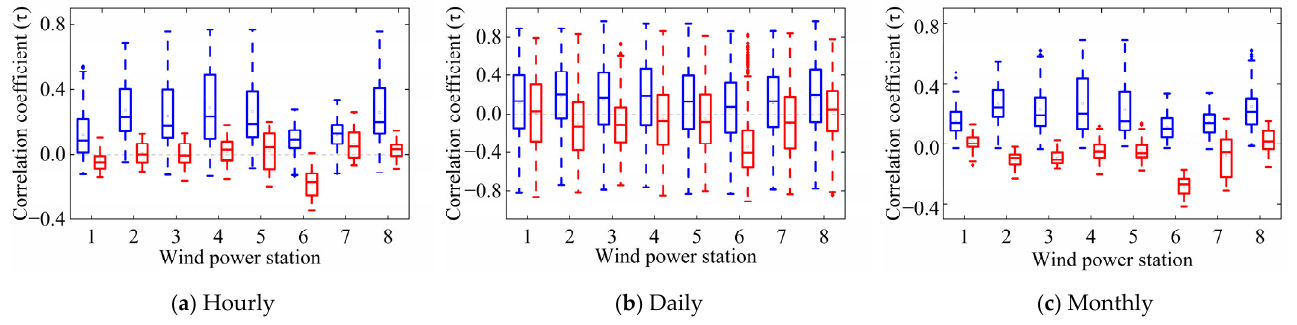
Figure 3. The fi rst type of complementary indicator under di ff erent time scales (the blue box represents the wind-wind mode, and the red box illustrates the wind-solar mode) .